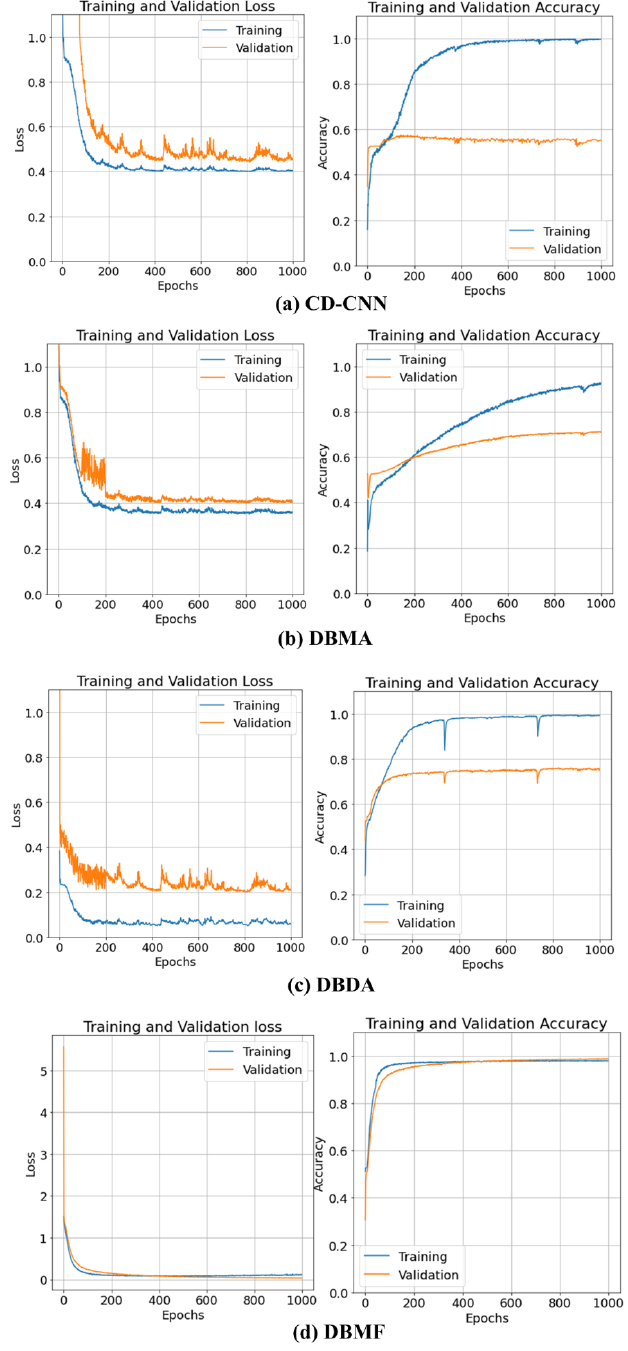
Figure 6. The loss and accuracy of compared models. Note: ( a ) The loss and accuracy of CD-CNN, ( b ) The loss and accuracy of DBMF. ( c ) The loss and accuracy of DBDA. ( d ) The loss and accuracy of DBMF.